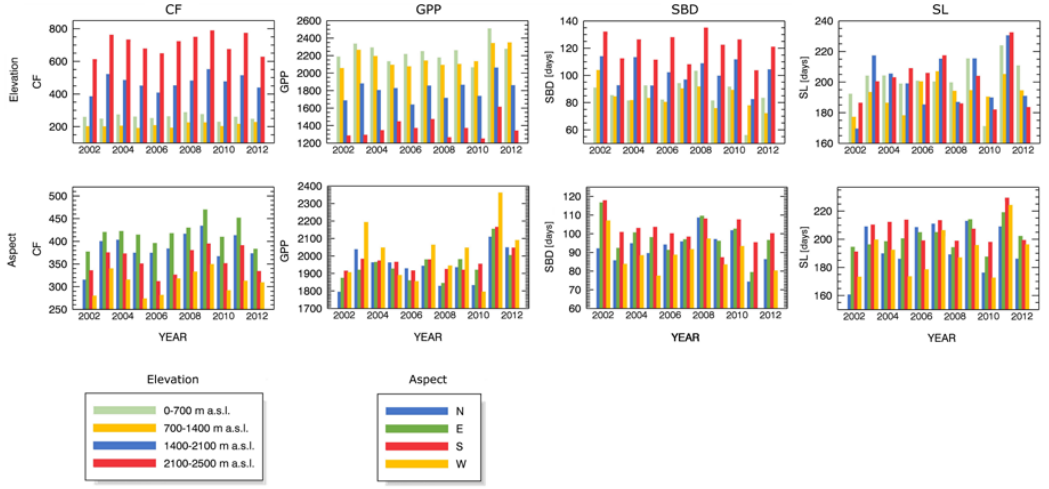
Figure 4. Marginal means plots of repeated measures ANOVA showing CF, GPP, SBD and SL variability (in columns) in relation to elevation and aspect (in rows). Analyses performed for the 4nNDII7 drought impact class 3 spatial footprint. Categories plotted in transparent comprise less than 50 observations. Abbreviations are explained in Figure 3.